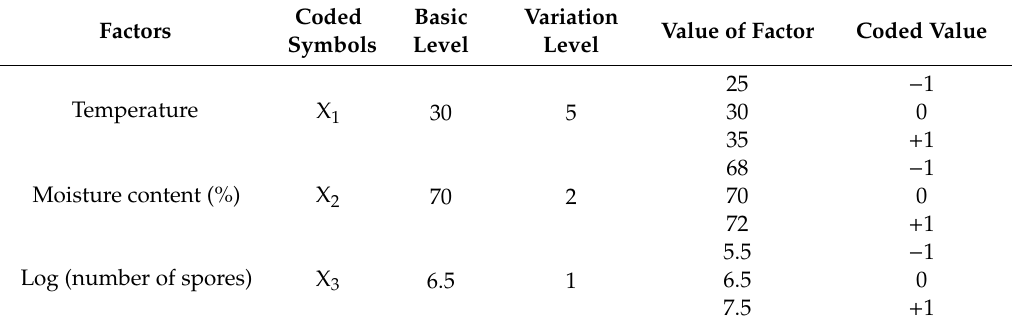
Table 1. Variables and level for Box–Behnken design for the optimisation of physical parameters. Coded Factors Symbols